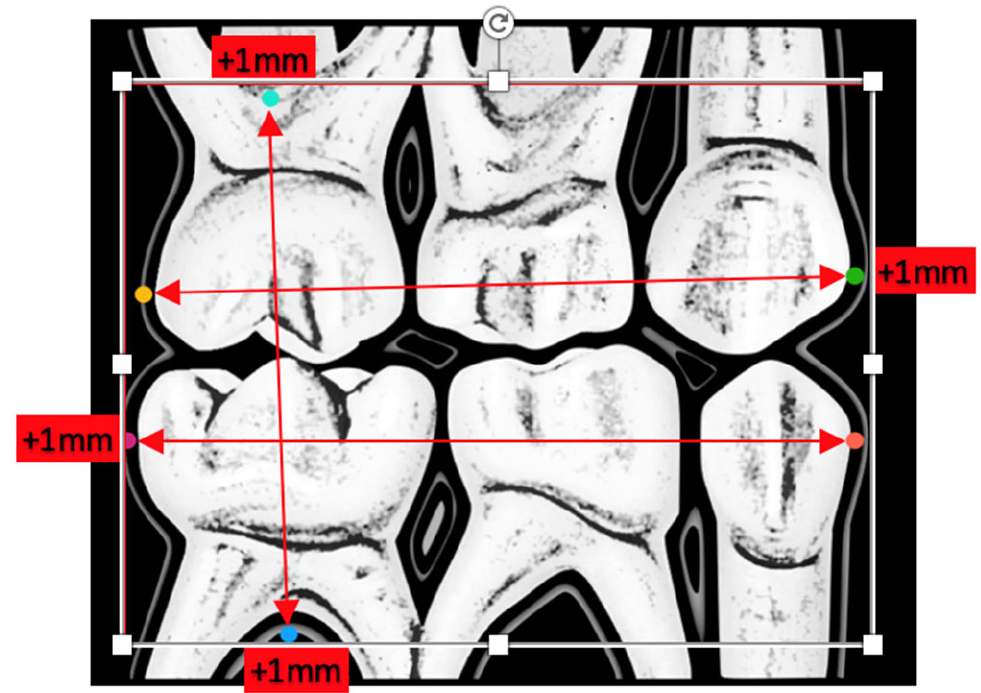
Figure 1. Anatomical points and lines taken as reference for the future size of the radiographic